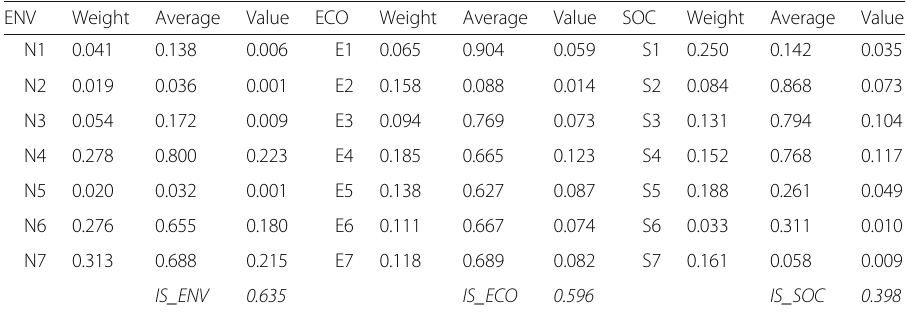
Table 2 Values of sustainability indices ENV